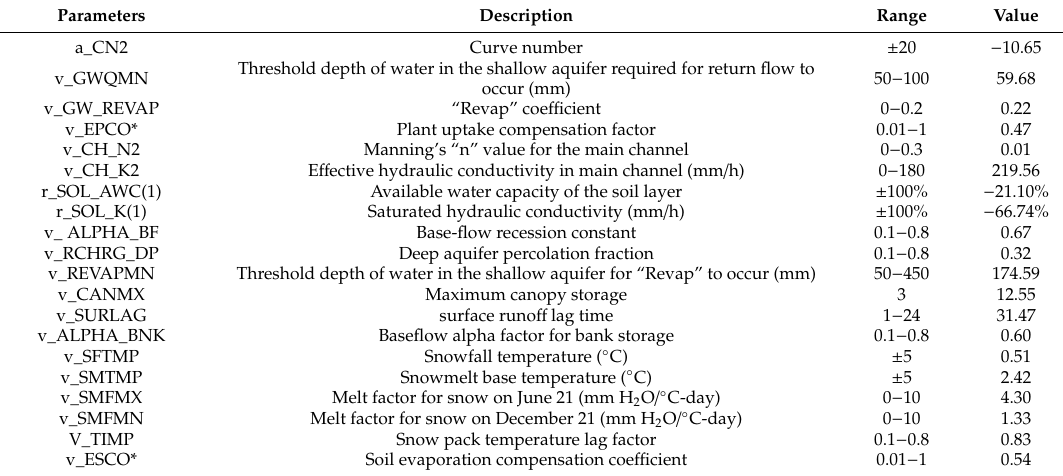
Table 1. Optimal parameter values calibrated for the Yiluo River